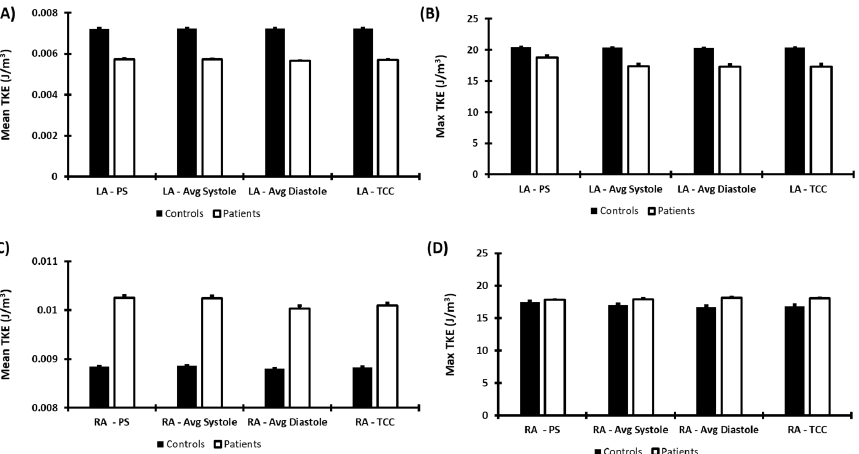
Figure 4. Turbulent kinetic energy in the left atria and right atria. Mean turbulent kinetic energy (TKE) and max TKE were calculated throughout the entire cardiac cycle, including peak systole (PS), average systole (avg systole), average diastole (avg diastole), and total cardiac cycle (TCC) in the Left Atria (LA) and Right Atria (RA) for both patients and controls. Panels ( A , B ) show the mean TKE and the max TKE in the LA for both controls and patients. Panels ( C , D ) show the mean TKE and max TKE in the RA. No statistical significance was observed between the two cohorts in the LA and